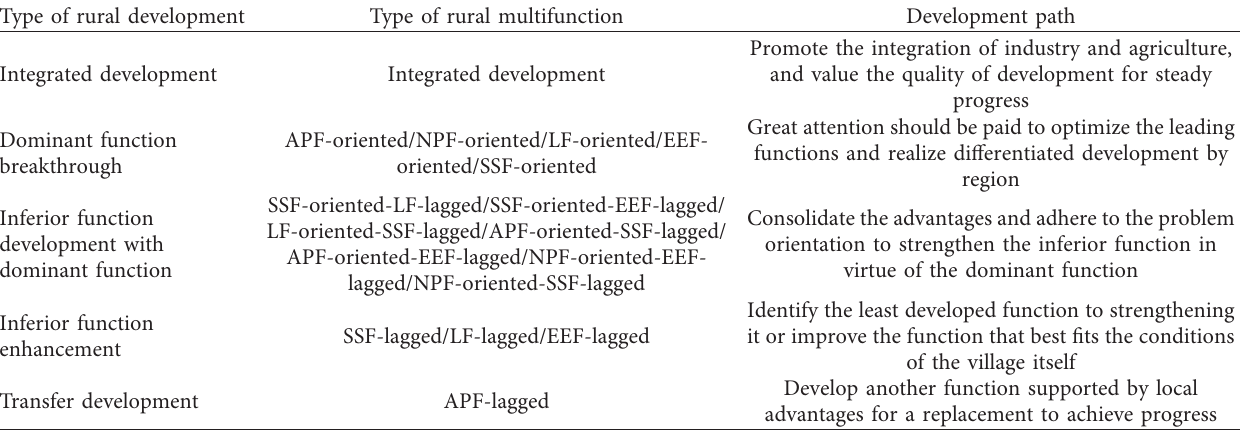
Table 3: Division of development types based on rural